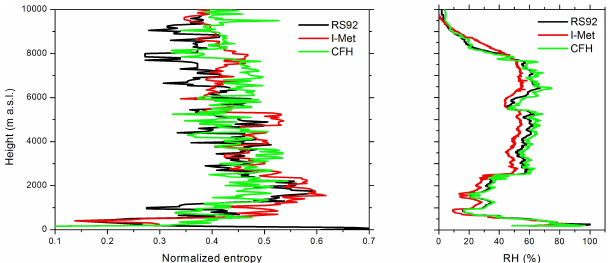
Figure 7. Comparison of the normalized entropy values (left) for the RS92 and Intermet radiosondes (I-Met) and the cryogenic frost- point hygrometer (CPH) measuring the in situ water vapour vertical profile at the Sodankyla site in 2010 (left panel); comparison of the relative humidity profiles in one case on 15 March 2010 (right panel).